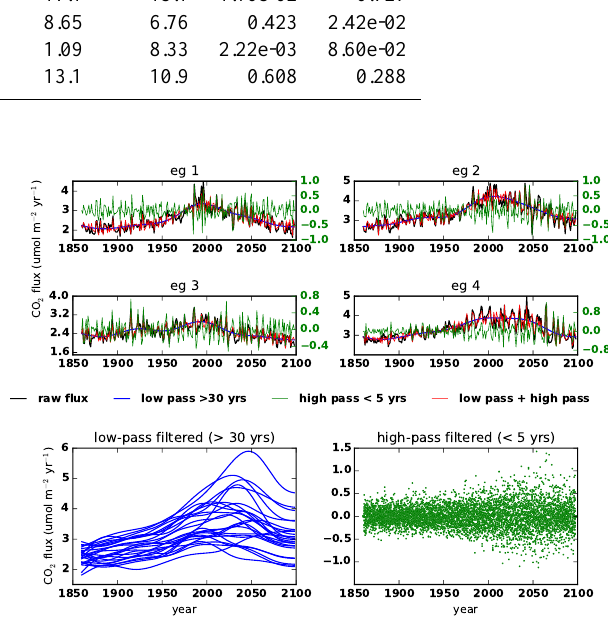
Figure 5. High and low pass filters are applied to the ESPPE sub- polar North Atlantic air–sea CO 2 flux simulations to identify the separate time-scales of variability. Top panel: four random ensem- ble members’ CO 2 flux is presented (black) alongside the low-pass (blue) and high-pass (green) processed fluxes. In red, the low and high pass filtered data are recombined to demonstrate that these timescales of variability together explain almost all of the origi- nal variability. Lower panel: the low-pass (blue, left) and high-pass (green, right) filtered results across all ensemble members are pre- sented, demonstrating, in the case of the low-pass filters results, great diversity in model